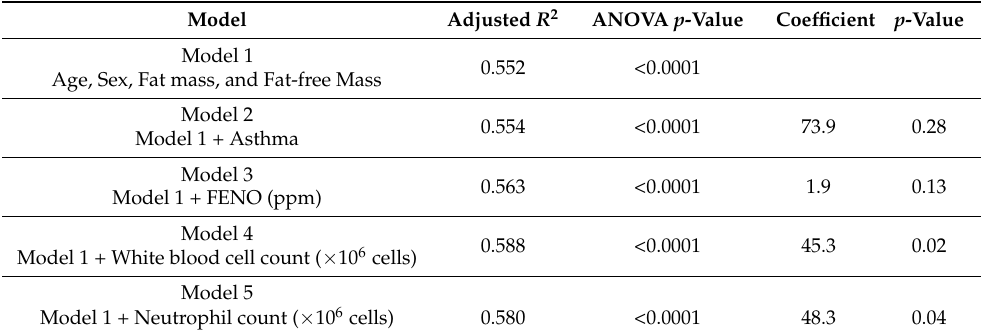
Table 5. Summary Statistics of REE Linear Regression Models.